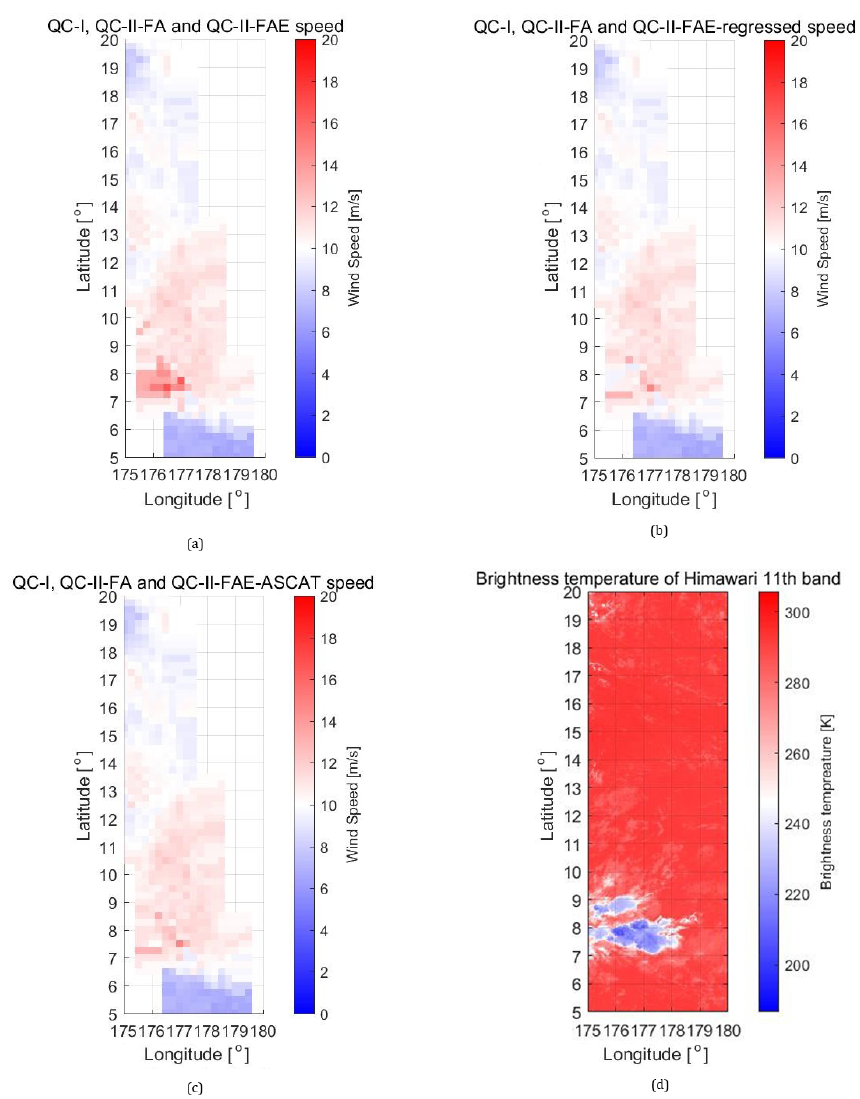
Figure 7. Wind speed of the QC-I, QC-II FA and QC-II FAE (a) , with the FAE set replaced by the SVM regressed speed (b) and by speeds from their ASCAT collocations (c) , with the synchronous MIR (e) images from Himawari-8, where the green rectangle indicates the region in panels (a) , (b) and (c) .